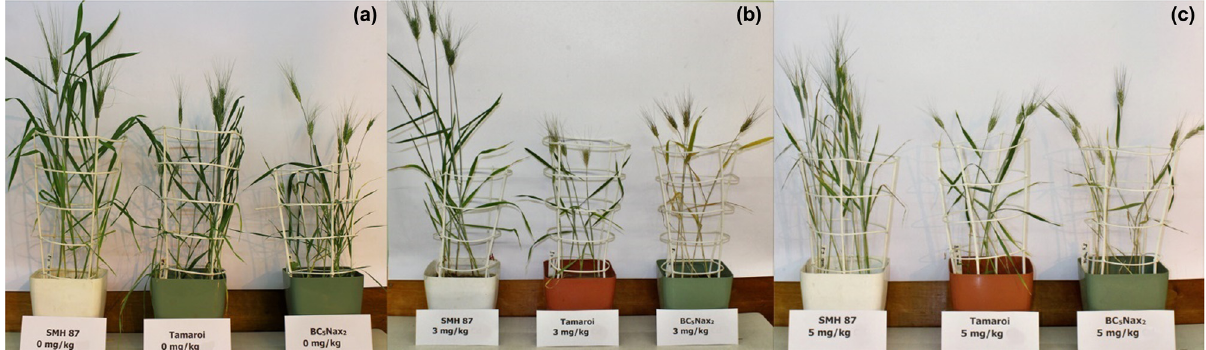
Figure 2: Plants of the studied genotypes, in the heading phase, growing in the soil without Cd ( control ) ( a ) and in the soil contaminated with 3 mg Cd kg − 1 DM ( b ) and 5 mg Cd kg − 1 DM ( c )